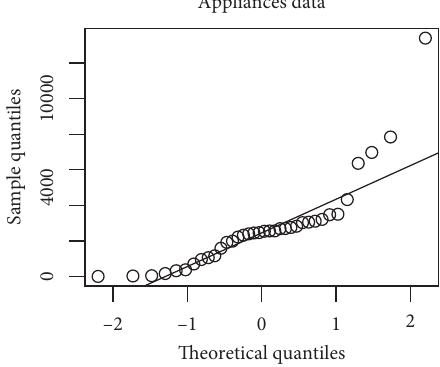
Figure 10: QQ plot of appliances. Figure 11: QQ plot for EEDL distribution on yarn